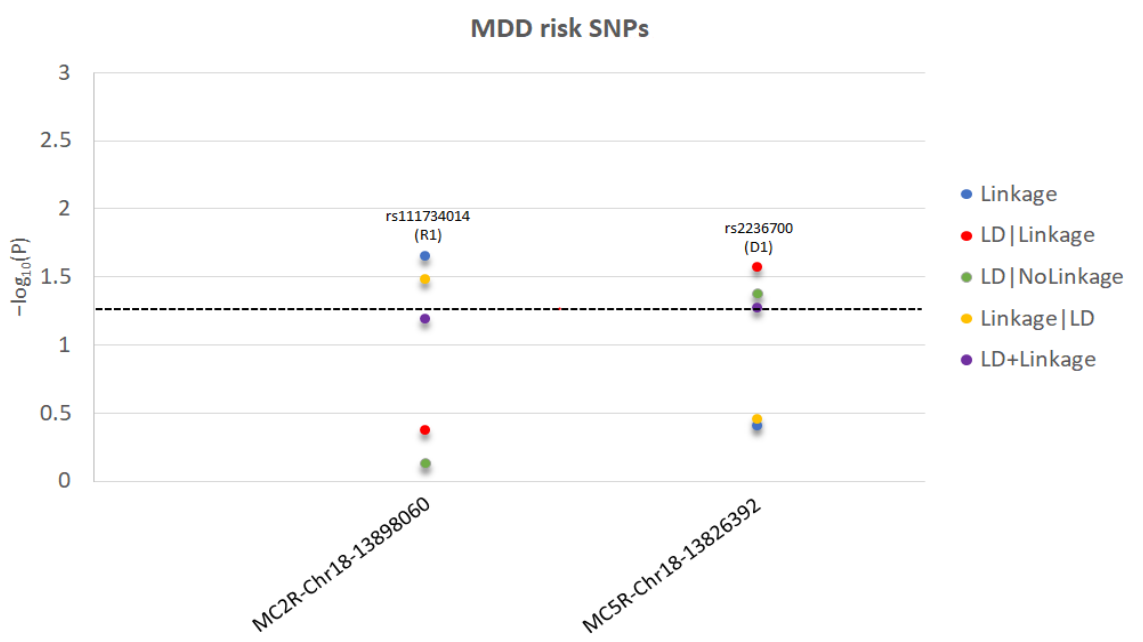
Figure 2. For each significant MDD-risk SNP in MC2R and MC5R genes, we present the − log10(P) as a function of each test statistic (Linkage, LD|Linkage, LD|NoLinkage, Linkage|LD, and LD+Linkage) and label the significant inheritance model: D1: dominant, complete penetrance; R1: recessive, complete penetrance. The level of statistical significance is marked by the dotted line.